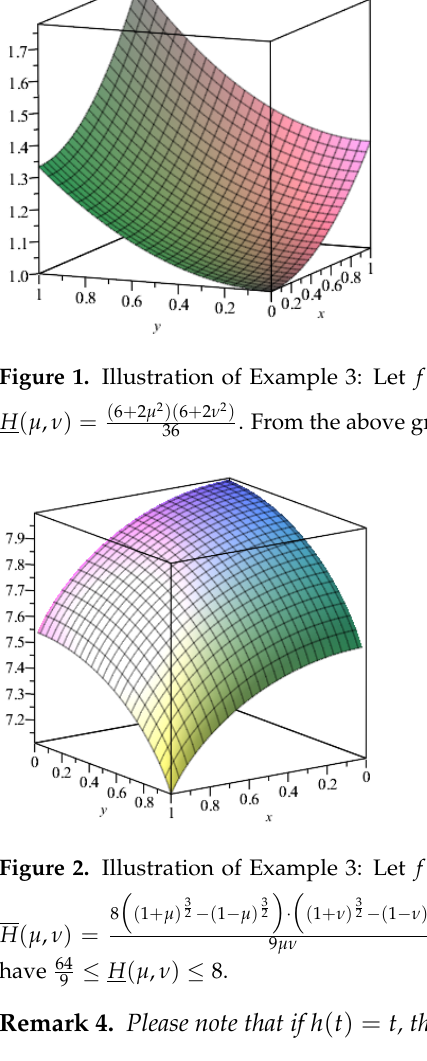
(cid:17) (cid:16) · ( 1 + ν ) 3 2 − ( 1 − ν ) 3 2 9 µν